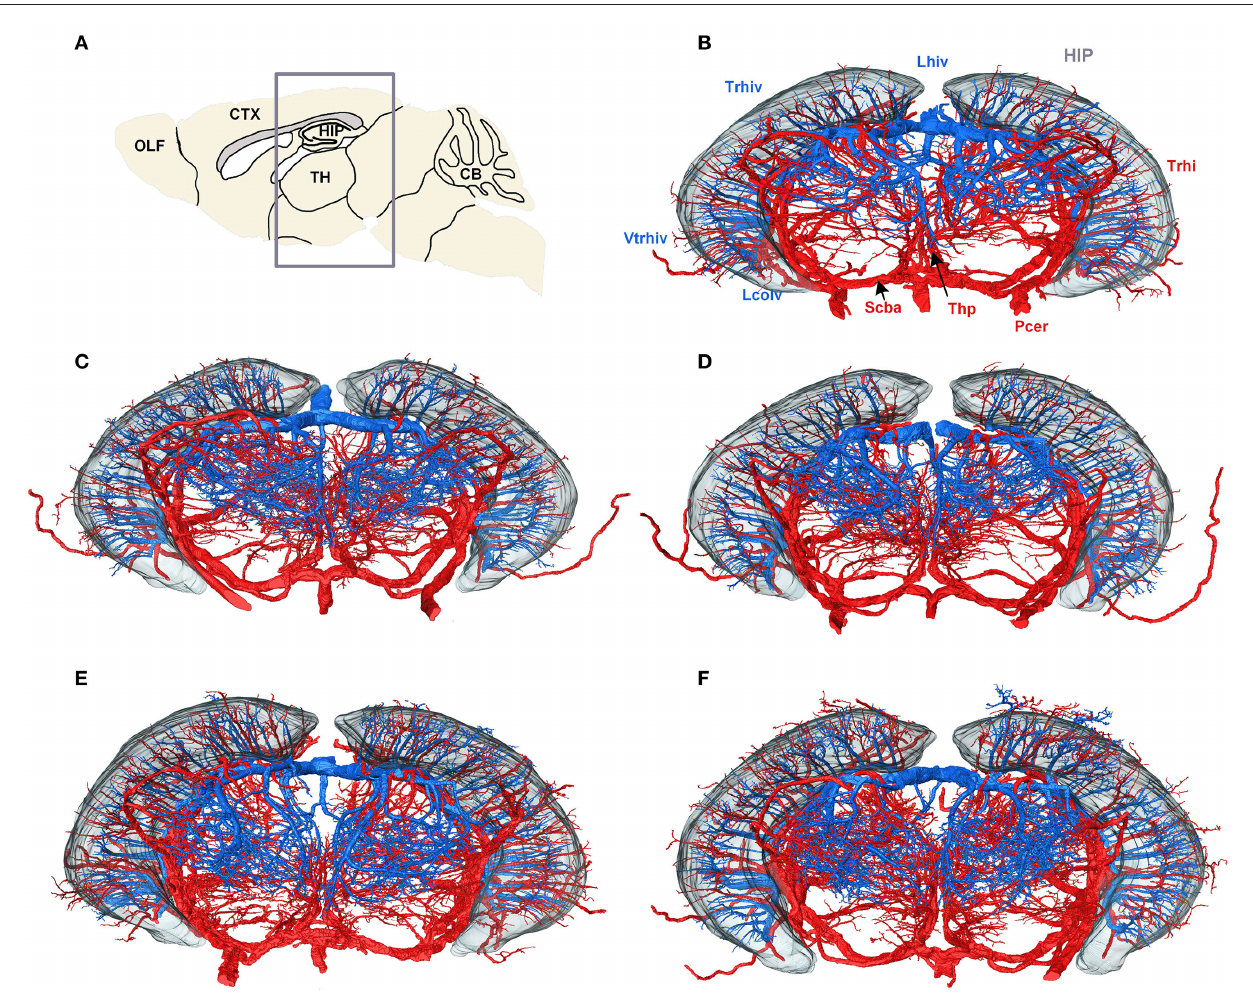
FIGURE 5 | Vascular conserved distribution results across five mouse brains. (A) Sagittal slice used for localization; the gray box shows the range in the rostral to the caudal direction of the 3D datasets in (B–F) . (B–F) Three-dimensional reconstructed results for Lhiv, Lcolv, and Pcer in five mouse brains. To identify the position and direction of the vessels in 3D, the contour of the HIP is shown as well. In (B) , the main branches of Pcer and Scba are marked in red, while the branches of Lcolv and Lhiv are marked in blue, and brain regions are marked in gray. A list of abbreviations and full names of the brain regions is presented in Supplementary Table 1, while the tree of abbreviations and the full names of vessels is presented in Figure 4